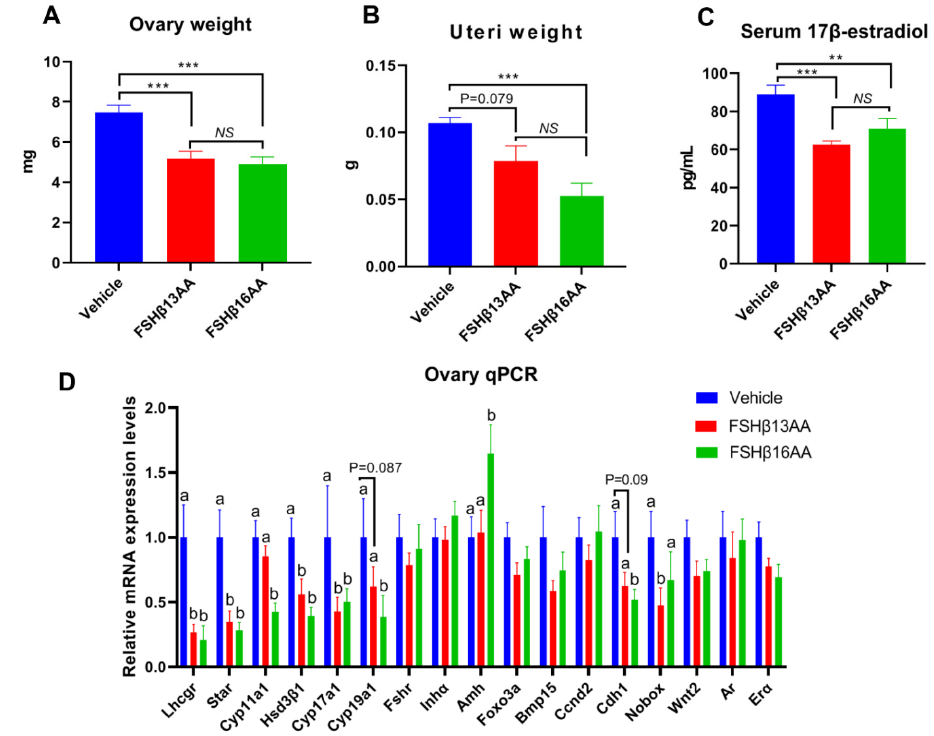
Figure 9. One FSH β 13AA/FSH β 16AA treatment during diestrus antagonizes the FSH ‐ stimulated responses during proestrus in adult female mice. The following data were collected from adult mice during proestrus: ( A ) Paired ovaries weight. ( B ) Uteri weight. ( C ) Serum concentrations of 17 β‐ es ‐ tradiol. ( D ) Ovarian mRNA expression levels of the steroidogenesis ‐ and follicle development ‐ as ‐ sociated genes. ** p < 0.01, *** p < 0.001, NS , not significant. a,b Means without a common letter differed ( p < 0.05). Lhcgr , luteinizing hormone receptor; Star , Steroidogenic acute regulatory protein; Cyp11a1 , cytochrome P450, family 11, subfamily A, member 1; Hsd3 β 1 , 3beta ‐ hydroxysteroid dehydrogenase type 1; Cyp17a1 , cytochrome P450, family 17, subfamily A, member 1; Cyp19a1 , cytochrome P450,family